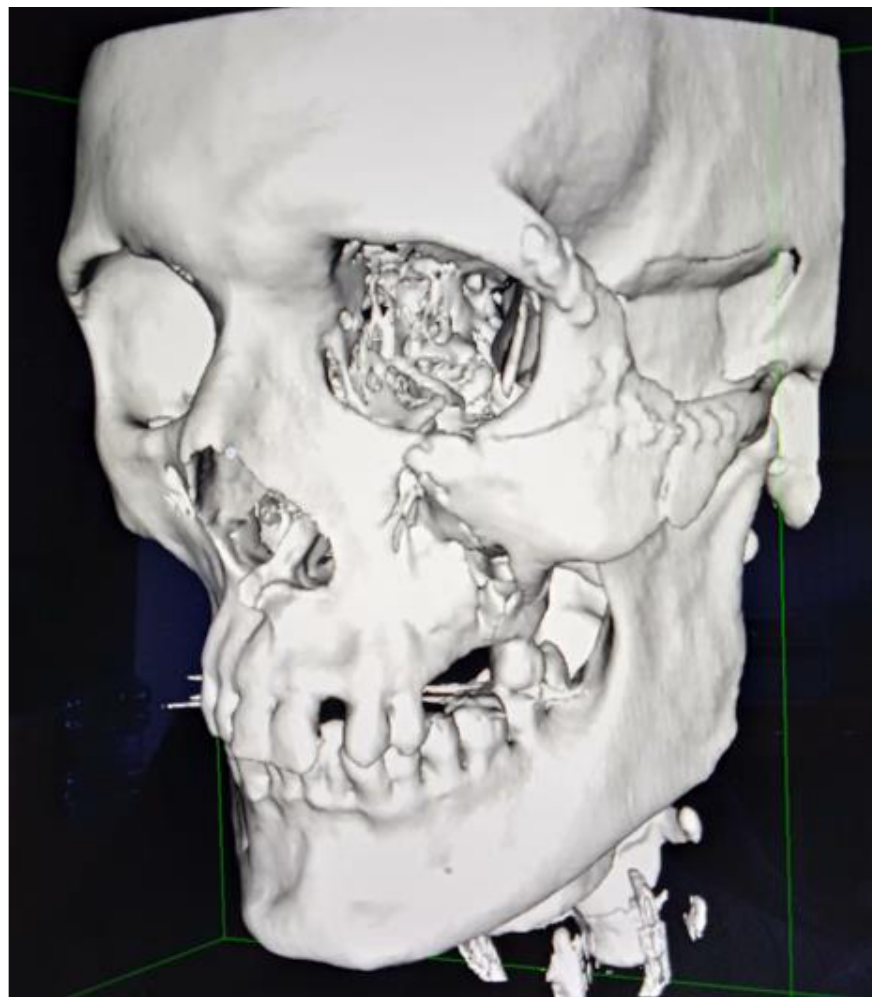
Figure 15. Postoperative fronto-lateral view on 3D-CT evaluation.